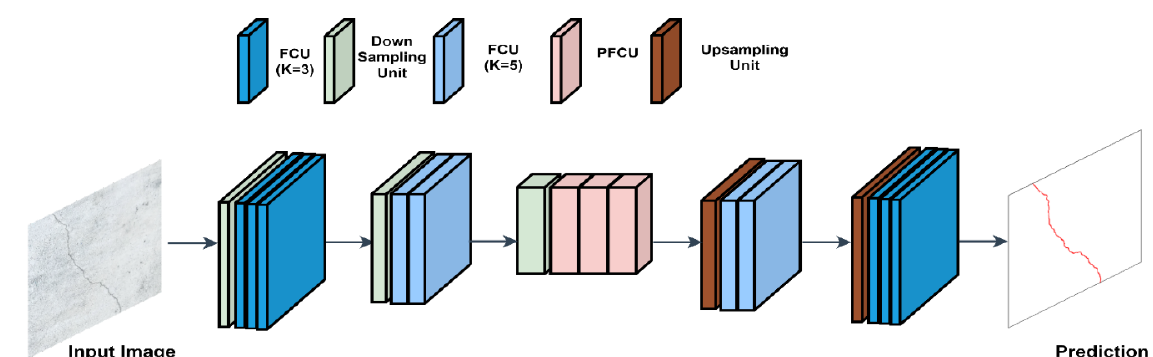
Figure 5. Overall symmetric encoder – decoder architecture of